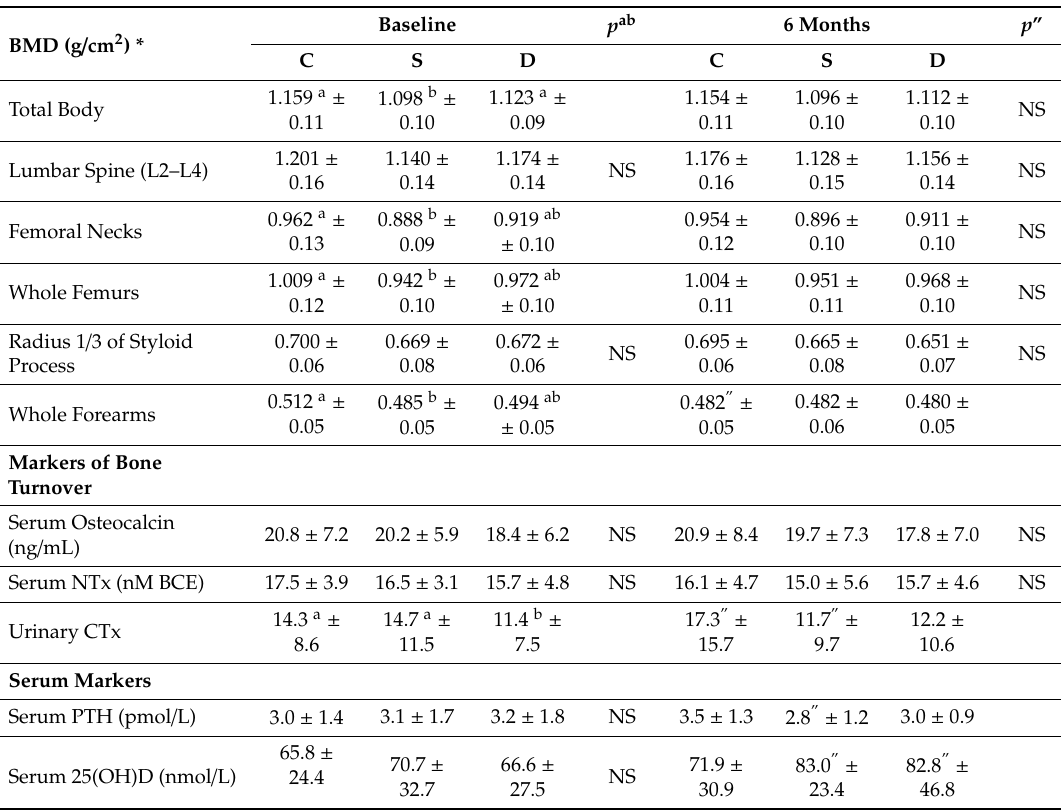
Table 2. Bone mineral density (BMD) of various skeletal sites, markers of bone turnover and serum biomarkers in participants among the groups at baseline and after 6 months (mean ± SD); n = 30, n = 37, n = 30 for control / placebo (C), supplement (S) and dairy (D) group, respectively. BMD (g / cm 2 )